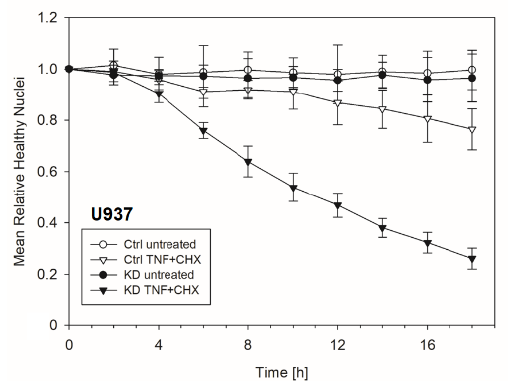
Figure 4. Enhanced apoptosis upon TNF + cycloheximide (CHX) stimulation of YB-1-deficient cells. The graph showing the normalized number of healthy nuclei per field of view over indicated period of time. The total number of healthy nuclei decreased after 4 h of TNF + CHX treatment.